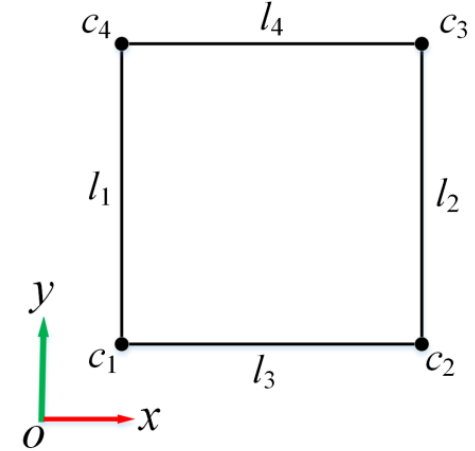
Figure 2. The classifications of nodes when using Bloch Floquet conditions. The Bloch Floquet conditions are applied on the boundary of the square lattice, which are l 1 , l 2 , l 3, and l 4 . In addition, c 1 ~ c 4 represent the four vertices of the square